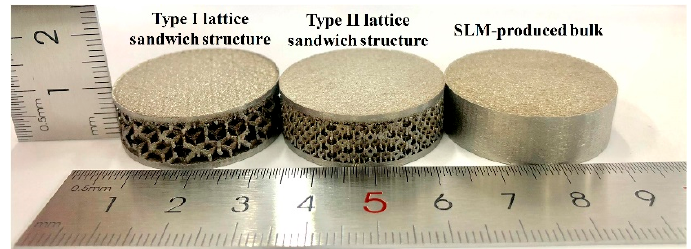
Figure 4. SLM-produced 316L stainless steel samples of the Type I lattice sandwich structure, Type II lattice sandwich structure and bulk for acoustic testing.